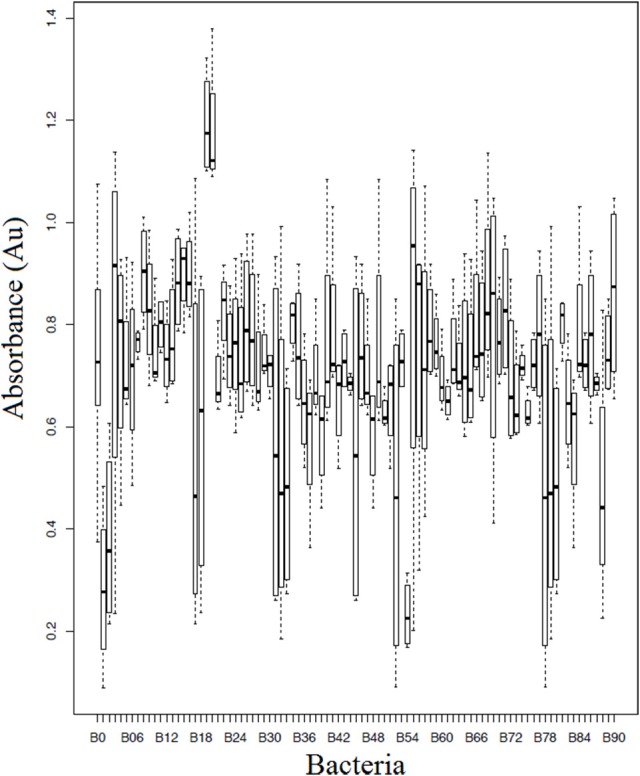
Box plot estimates of the cell-free supernatant challenge assay for each of the bacteria strains. The box represents the interquartile range (IQR) and the top and bottom whiskers represent Q3—(1.5 IQR) and Q1—(1.5 IQR), respectively. Bacteria IDs on the x-axis are referenced in Supplementary Table 3. Lower values signify greater inhibition of Bd growth. B0 corresponds to a Bd-only control.